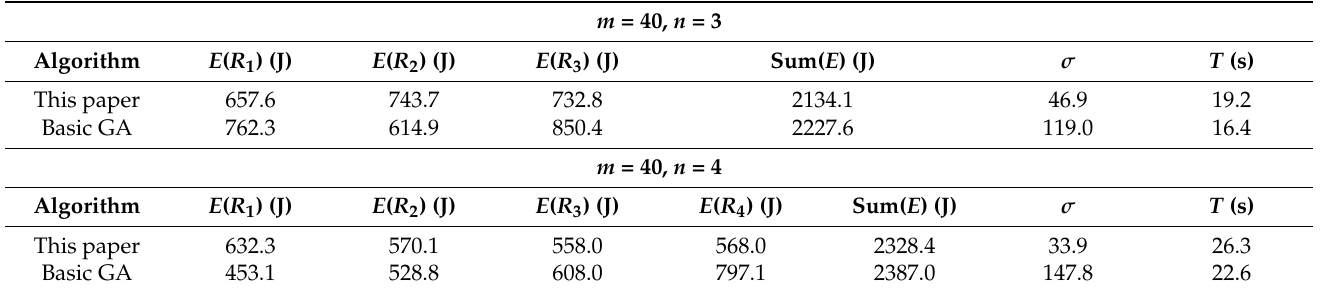
Table 2. Comparison of algorithm parameters from Experiment 2.